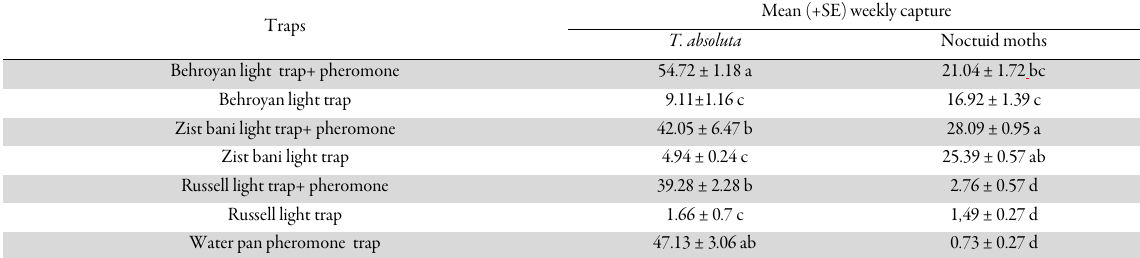
Table 2. Mean weekly captured of T. absoluta adults and noctuid moths (mean ±SE) in experimental traps during whole growing season of tomato